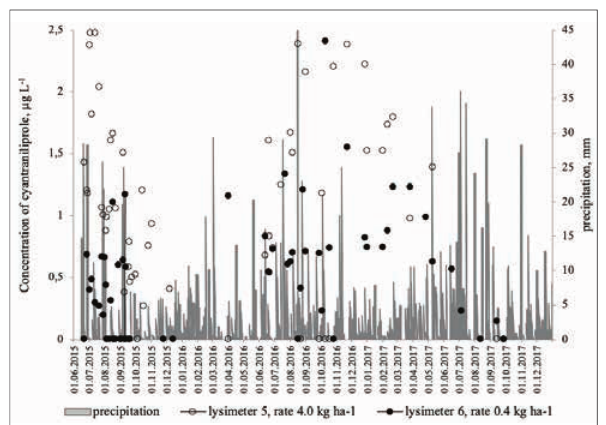
Figure 5: Precipitation and cyantraniliprole concentration in leachate